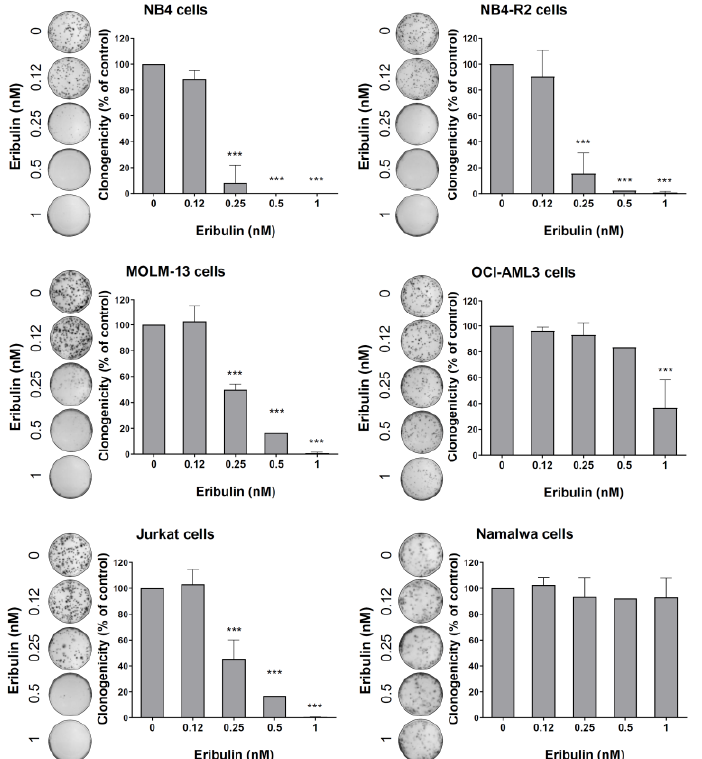
Figure 5. Eribulin reduces the clonogenicity of leukemia cells. Colonies containing viable cells were detected by adding an MTT reagent after eight days of culturing the cells in the presence of vehicle or eribulin (0.12, 0.25, 0.5, and 1 nM). Colony images are shown for one experiment, and bar graphs show the mean ± SD of at least three independent experiments. *** p < 0.0001; ANOVA test and Bonferroni post-test.